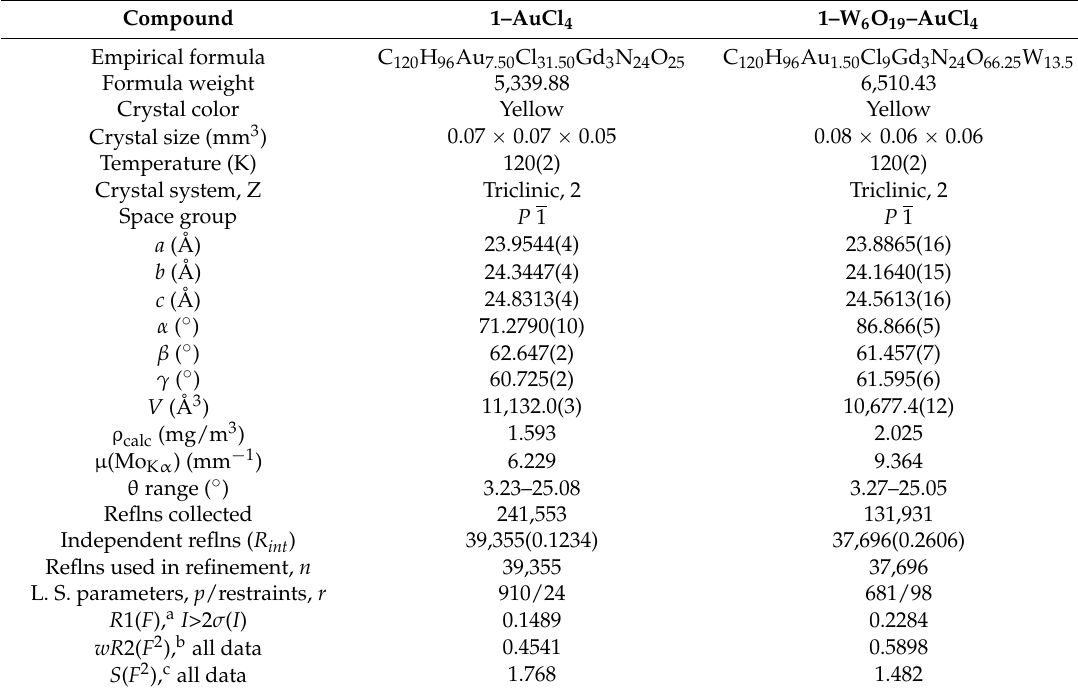
Table 2. Crystallographic data for compounds 1–AuCl 4 and 1–W 6 O 19 –AuCl 4 .